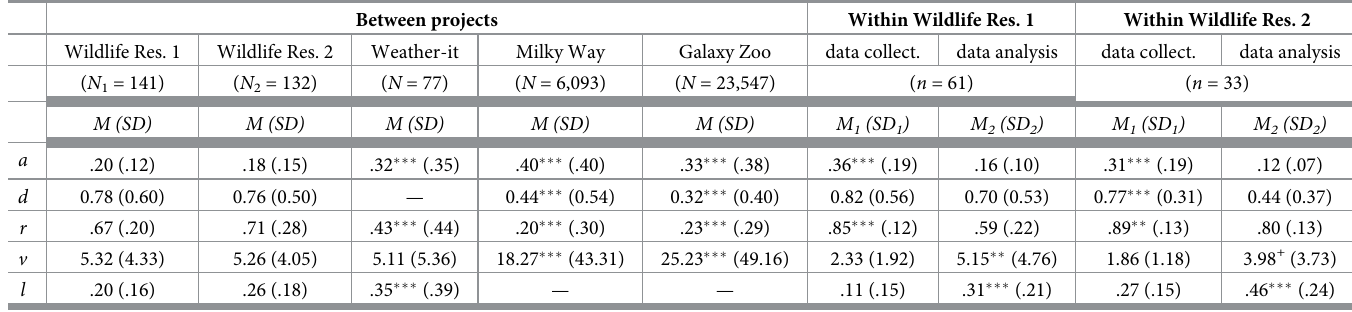
Table 1. Engagement metrics for two field studies of our CS project and three other CS projects (between projects) and, separately, for the data collection and data analysis phases in the two field studies of our CS project (within ‘Wildlife Researchers 1’, within ‘Wildlife Researchers 2’). Between